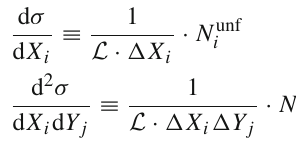
area represents the combined statistical and systematic uncertainties (describedinSect.9)inthetotalprediction,excludingsystematicuncer- taintiesrelatedtothemodellingofthe t ¯ t events.Underflowandoverflow events, if any, are included in the first and last bins. The lower panel shows the ratio of the data to the total